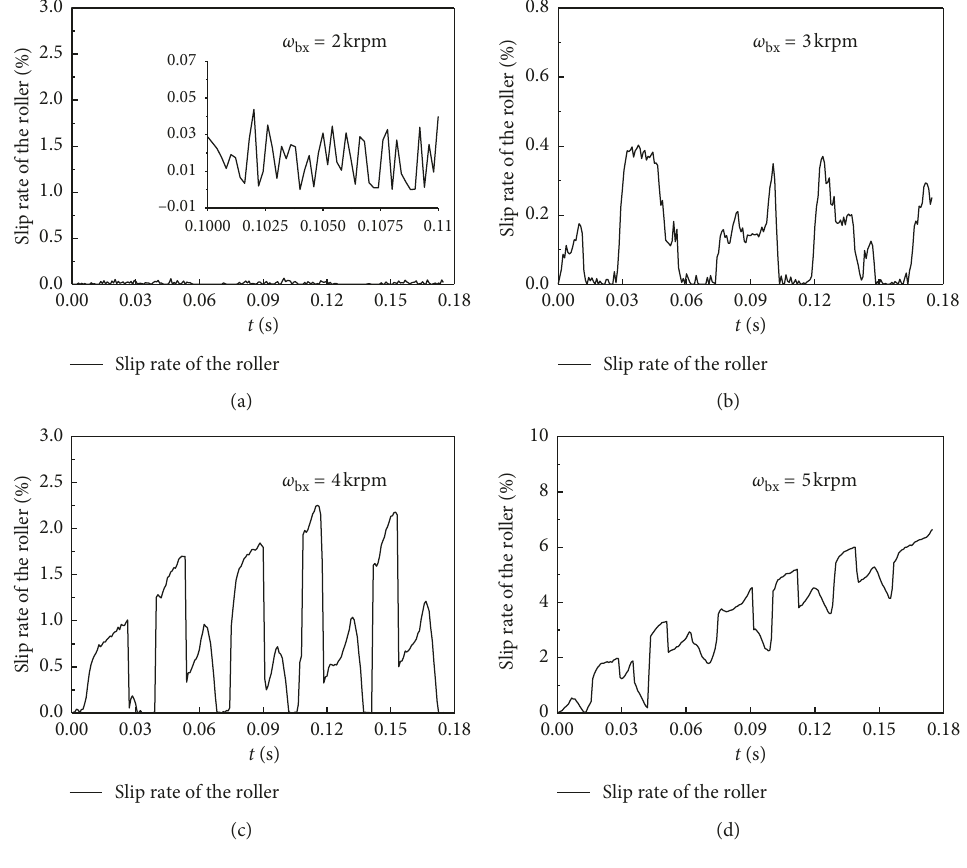
� 20kN; F � 0; ω � 2 ∼ 5krpm. r a bx